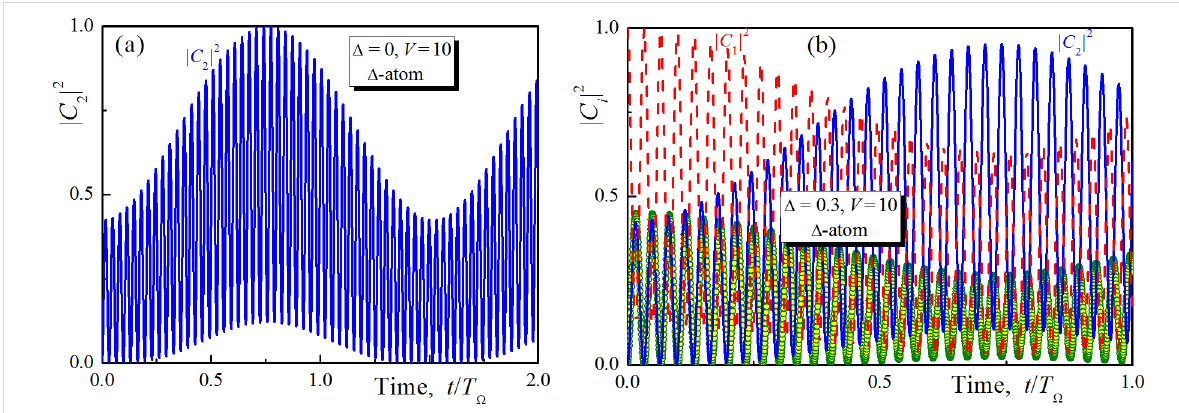
Figure 5: Population of the upper qubit state of the superconducting meta-atom obtained analytically for V = 5 in the limit of Δ→ 0 (a) and the popula- tions of the all considered states calculated numerically for Δ = 0.3, V = 10 (b). The direct transition between the qubit states is allowed. Dashed lines, solid lines and circles are for | C 1,2,3 | 2 , respectively.